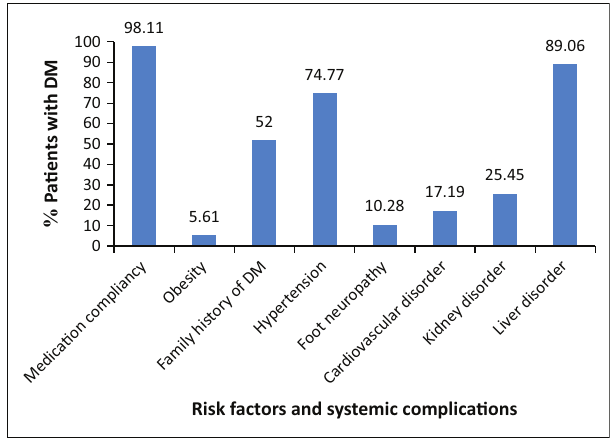
DM, diabetes mellitus. FIG URE 1: Risk factors and complications associated with diabetes